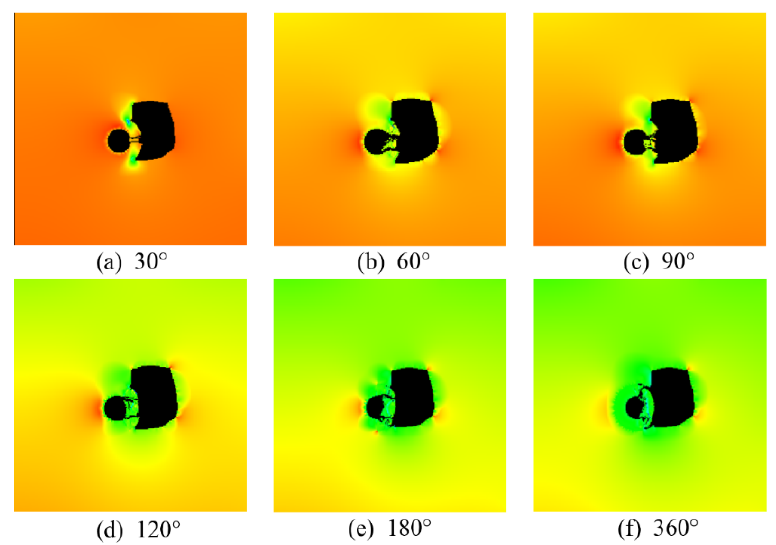
Figure 9. Numerical calculation results of damage characteristics of grouting for different grouting ranges: ( a ) grouting range of 30 ◦ ; ( b ) grouting range of 60 ◦ ; ( c ) grouting range of 90 ◦ ; ( d ) grouting range of 120 ◦ ; ( e ) grouting range of 180 ◦ ; ( f ) grouting range of 360 ◦ .